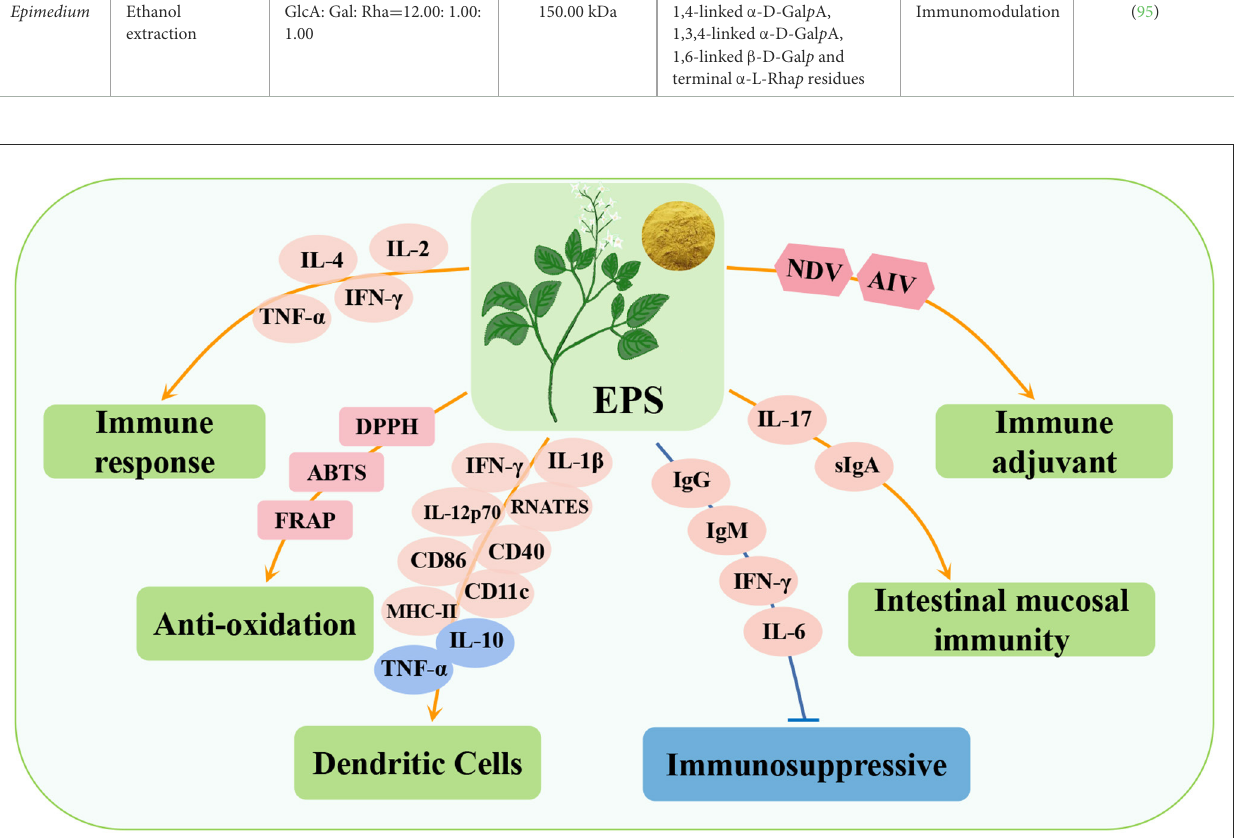
FIGURE5 Immunomodulatory effects of Epimedium polysaccharide (EPS) in poultry. FRAP, ferric ion reducing antioxidant power; IL-12p70, interleukin-12p70; RNATES, regulated on activation normal T-cells expressed and secreted; CD86, CD86 molecule; CD40, CD40 molecule; CD11c, integrin subunit alpha